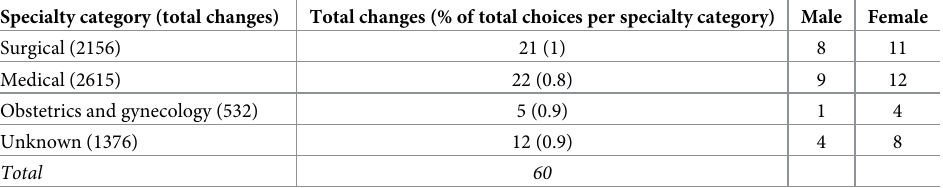
Table 3. Number of changes to laboratory test result preferences per